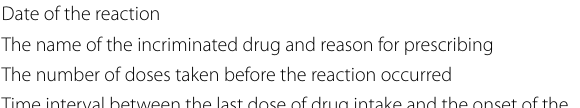
a It is a clinical dermatological sign characterized by detachment of the epidermis when rubbing the skin with weak or moderate pressure. The sign is positive if when exerting a slight pressure there is detachment of the skin, leaving wet and red areas